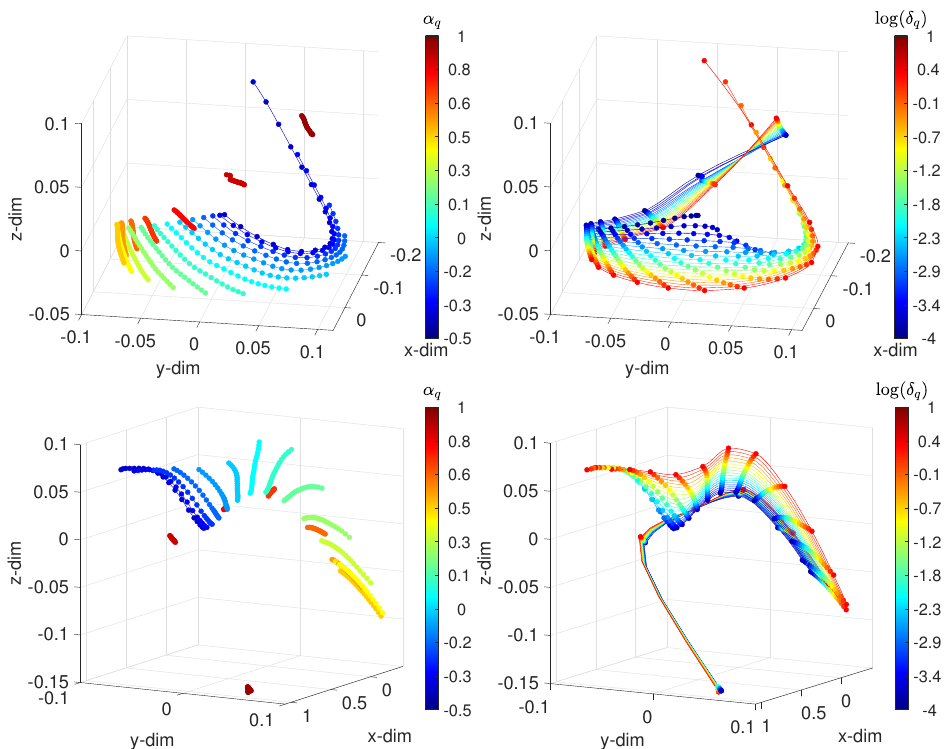
Figure 6. The 3-dim MDS locus for the IVSC-FSM, assessing the frequency-domain behavior, with the distances: ( top ) ( f ) ( f ) ( f ) ) ; and ( bottom ) Jaccard d ( v ( f ) ) . The points represent the test cases. On the left, lines connect Arccosine d 1 ( v , v , v 2 i j i j points of constant δ , and each color corresponds to points of constant α . On the right, lines connect points of constant α , and each color corresponds to points of constant δ . The fractional order α q ∈ [ − 0.5,1 ] , the width of the band δ q ∈ [ 10 − 4 ,10 1 ] , and f r ∈ [ 10 − 2 ,10 2 ]